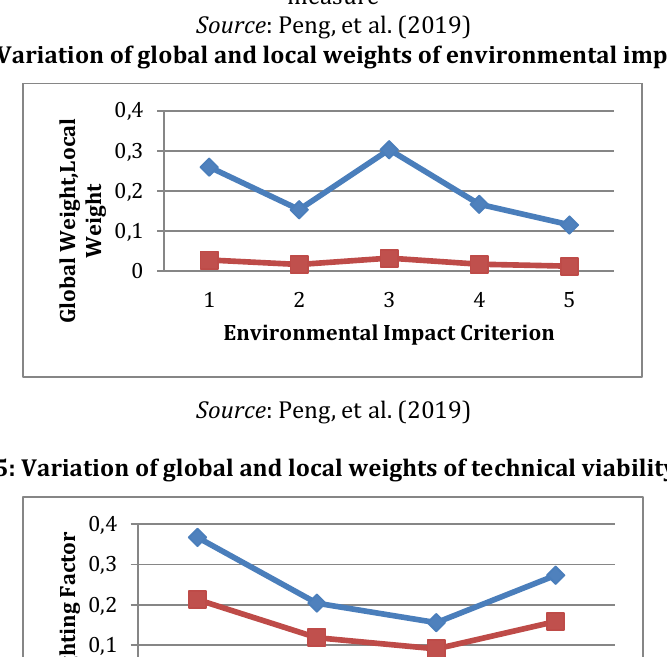
(1): Environmental impact Measure, (2): Economic viability measure, (3): technological viability